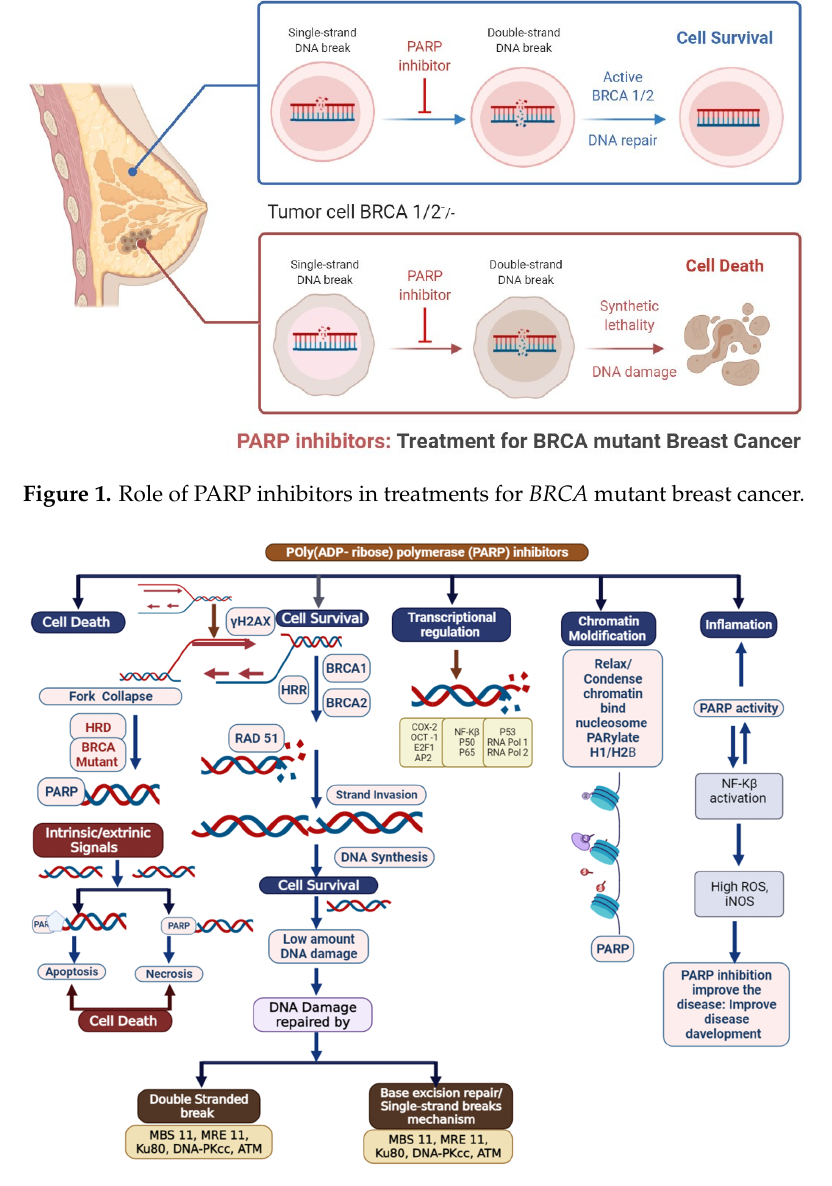
Figure 2. Schematic delineating the multifaceted nature of poly (ADP) ribose polymerase (PARP): DNA repair, chromatin modification, inflammation, transcriptional regulation, and cell death. Po- tential role of elevated PARP-1 in tumorigenesis. After DNA damage, PARP-1 activates DNA repair. However, PARP-1 also acts as a co-activator of NFkB signaling, which can propagate inflammatory signaling and lead to more DNA damage, including the formation of oxidatively clustered DNA lesions (OCDLs). The formation of OCDLs is elevated in numerous tumor types. PARP-1 activity